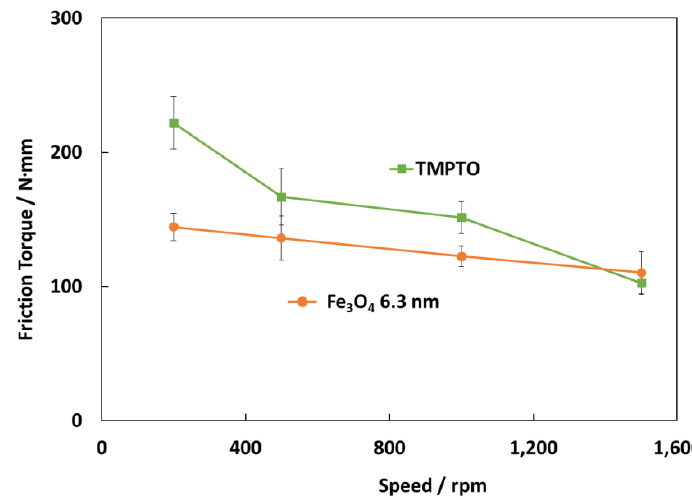
Figure 17. Friction torque results for the rolling bearing lubricated with the TMPTO base oil and TMPTO + 0.015 wt% Fe 3 O 4 (6.3 nm)